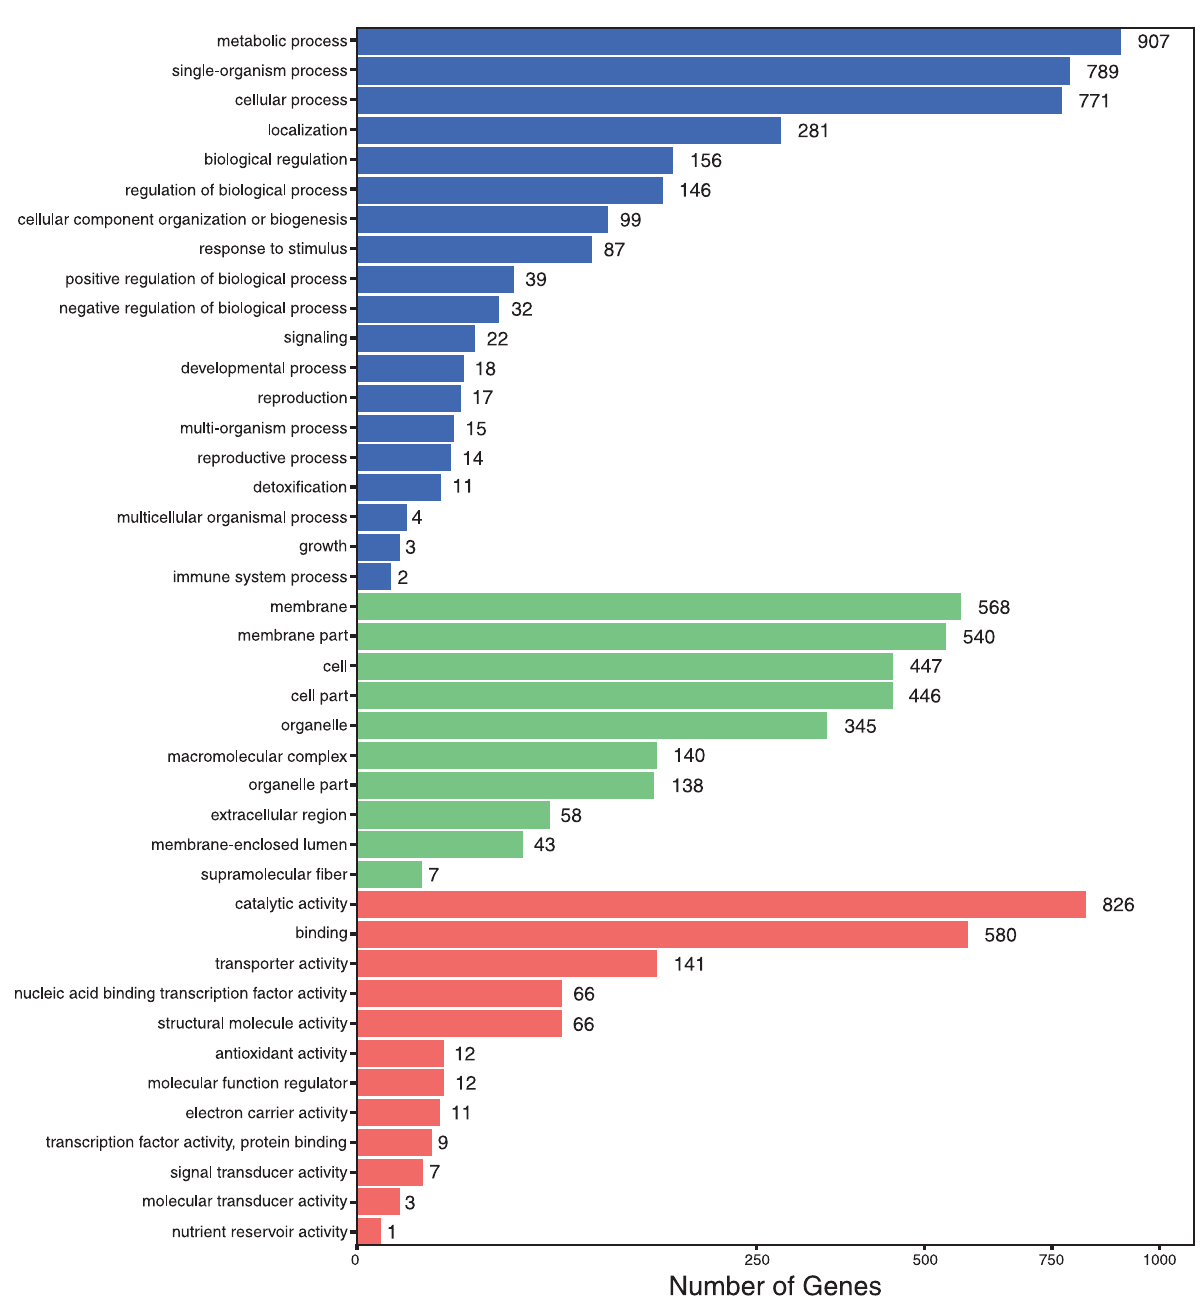
Fig 3. Gene function analysis of the differential expressed genes of RNA-seq analysis of Aspergillus terreus incubated at 25 ˚C-pH 7 and at 45 ˚C-pH 3 based on Gene Ontology (GO). The differential expressed genes could be referred to 19 categories in biological process, 10 categories in cellular component and 12 categories in molecular